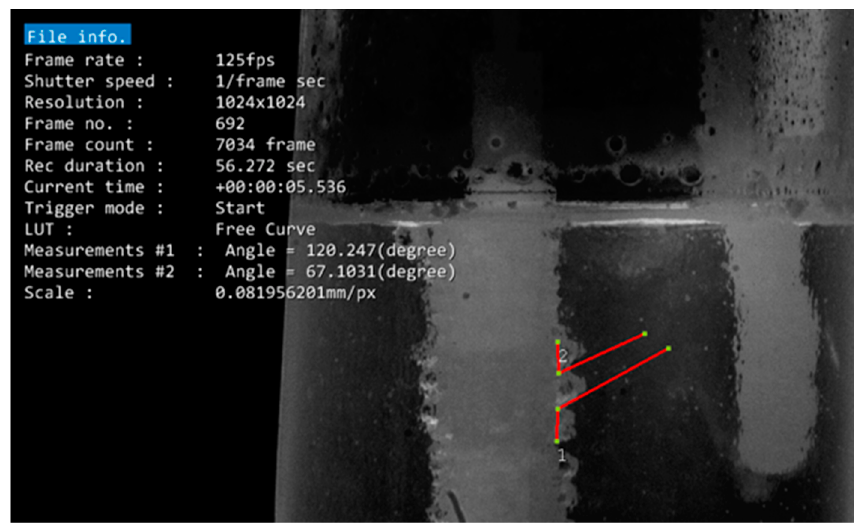
Figure A3. An example of measurement of wetting angle of the bubble on the horizontal anode just before it started to slide toward the edge of the anode to be detached during electrolysis at an average current density of 0.7 A cm − 2 .